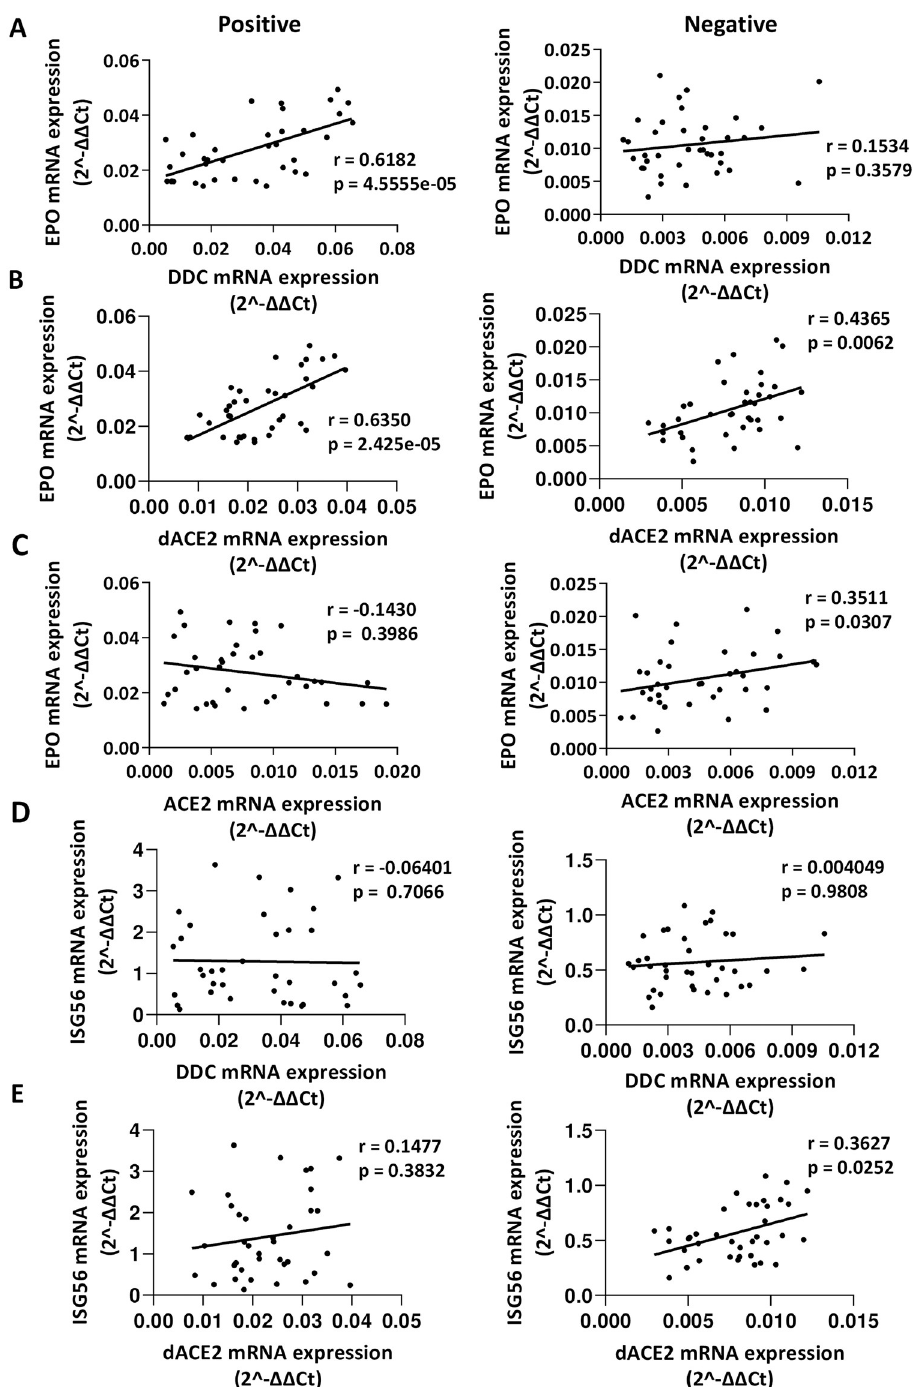
Fig 7. Correlation of EPO and ISG56 with DDC , dACE2 and ACE2 gene expression levels in SARS-CoV-2-positive and negative nasopharyngeal swab samples. XY scatter plot and fitted linear regression lines of the mRNA levels of ( A ) DDC versus EPO , ( B ) EPO versus dACE2 , ( C ) EPO versus ACE2 , ( D ) ISG56 versus DDC, and ( E ) ISG56 versus dACE2 , in positive (left) and negative (right) samples. Pearson’s or Spearman’s correlation coefficient ( r ) and p values ( p ) were calculated.